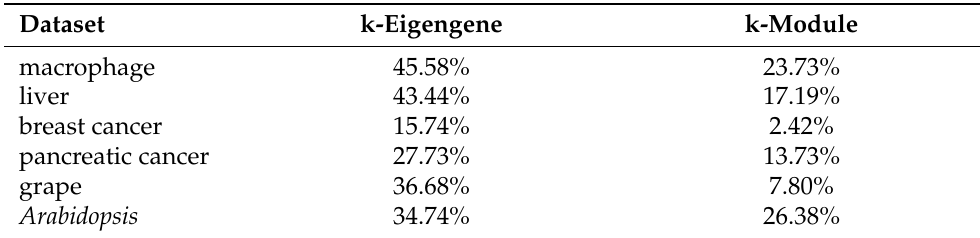
Table 2. The change rate of gene labels obtained by the k-eigengene and k-module algorithms. The k-module changes a small number of the gene